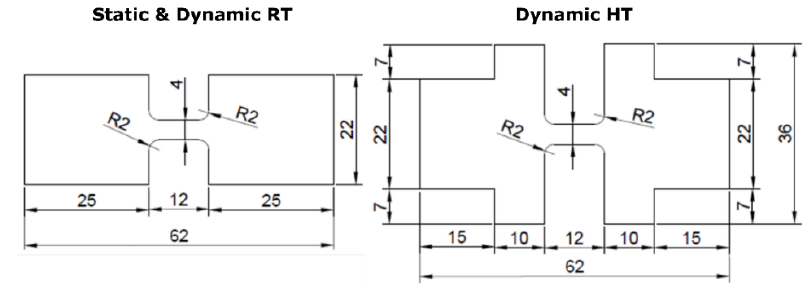
Figure 2: Geometry of the tensile specimens for RT and HT (thickness =